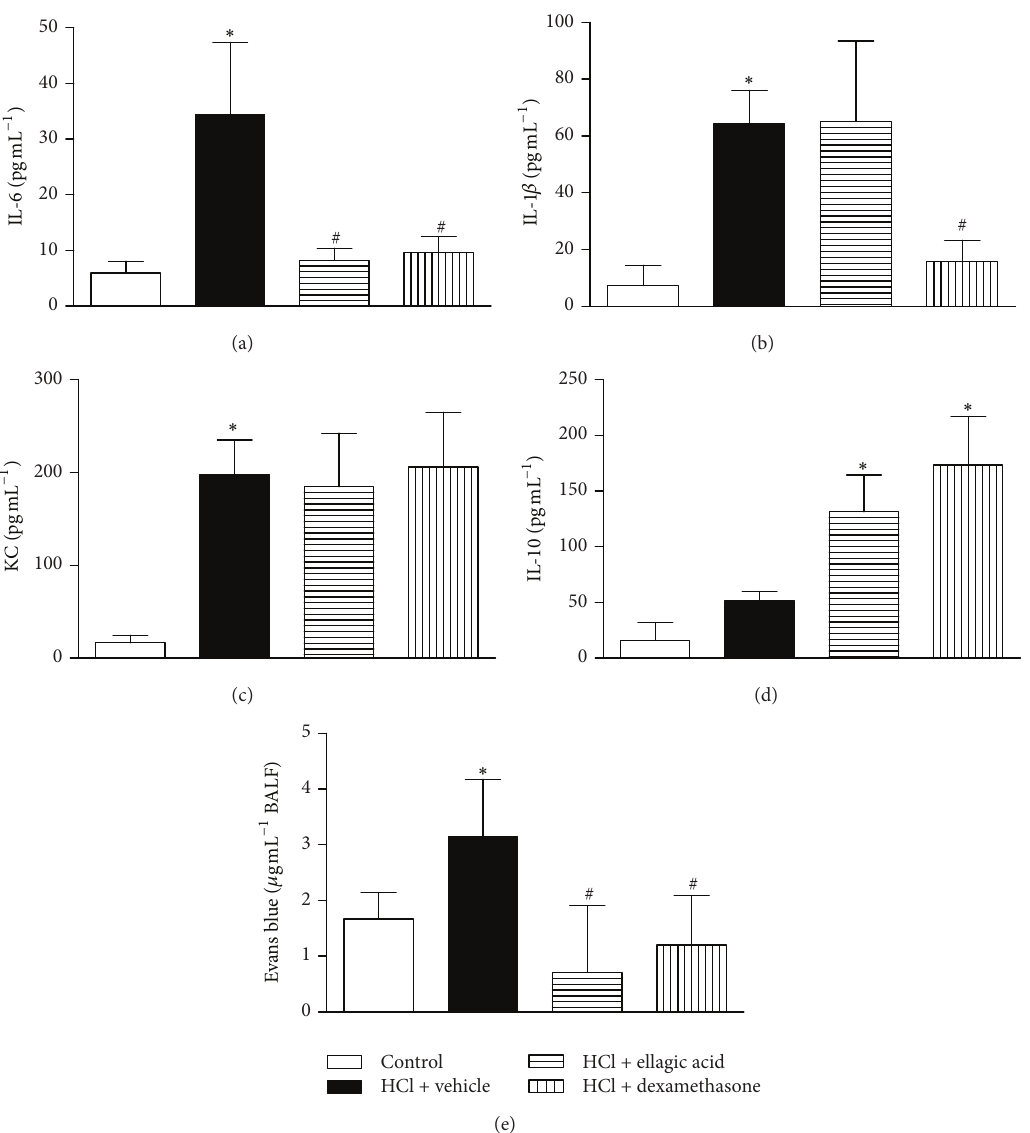
Figure 3: Effect of the therapeutic treatment with ellagic acid on IL-6 (a), IL-1 𝛽 (b), KC (c), and IL-10 (d) levels in BALF. Evans Blue dye extravasation into BALF was also determined 12 h after ALI (e) (see Materials and Methods). Mice received in the therapeutic scheme ellagic acid (10mg/kg, p.o.), dexamethasone (1mg/kg, s.c.), or vehicle (water, p.o.) after (2h) the acid intratracheal instillation into the left lung (see Methods). The analyses of lung were carried out in the peak of inflammation (12h). Results represent the mean ± SEM of two or more independent experiments with three mice per group per experiment. ∗ 𝑃 < 0.05 compared with control group; # 𝑃 < 0.05 compared with HCl + vehicle